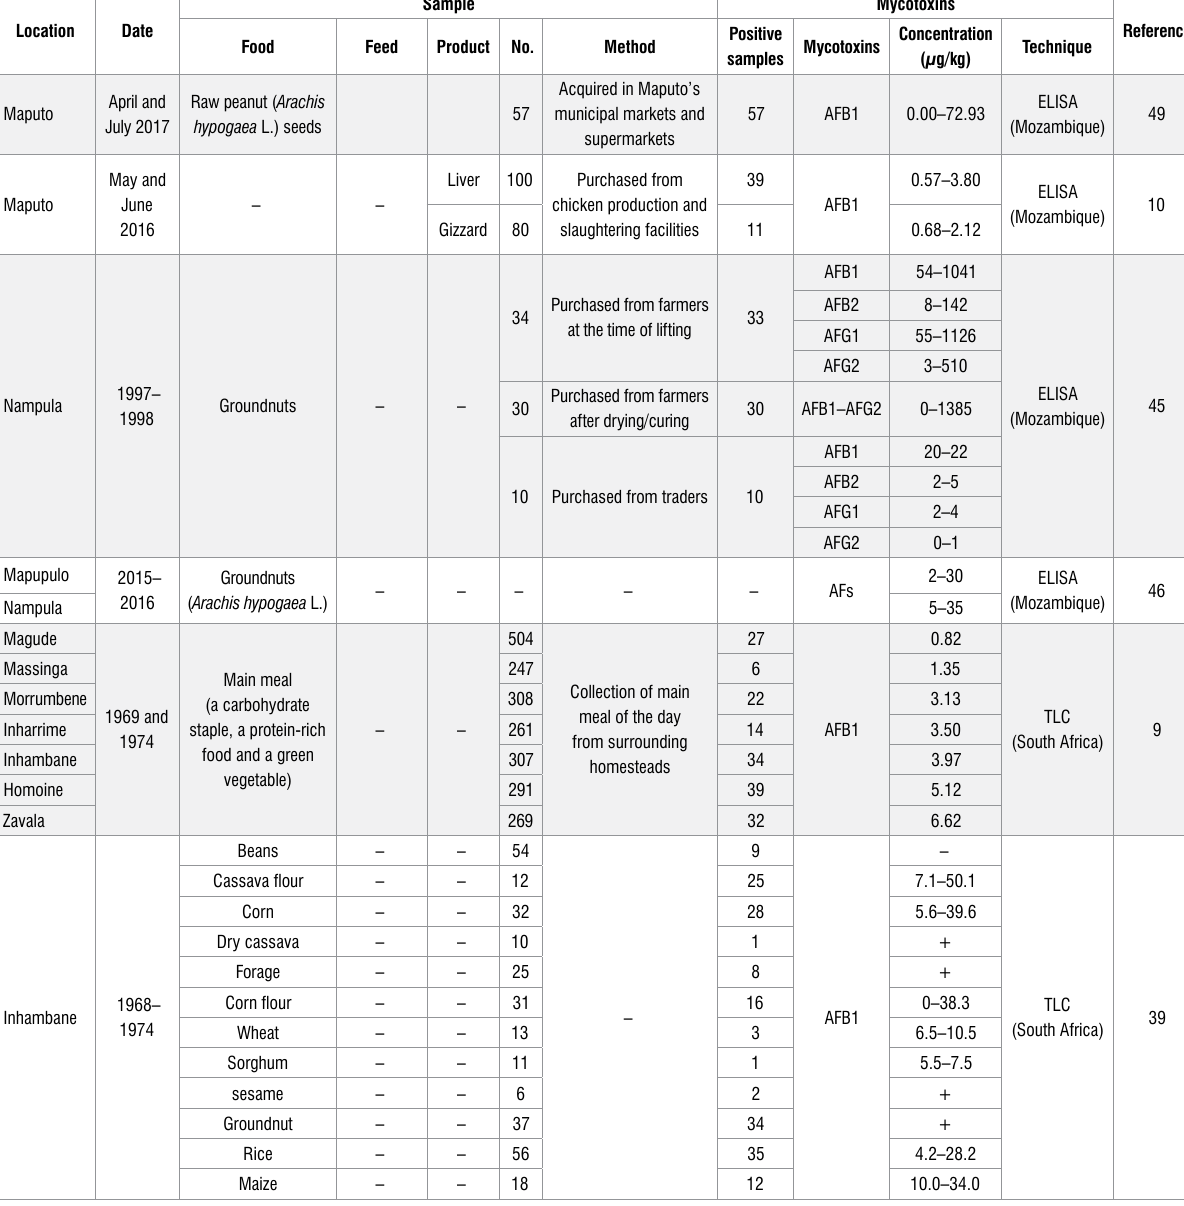
Table 2: Mycotoxins found in food in Mozambique